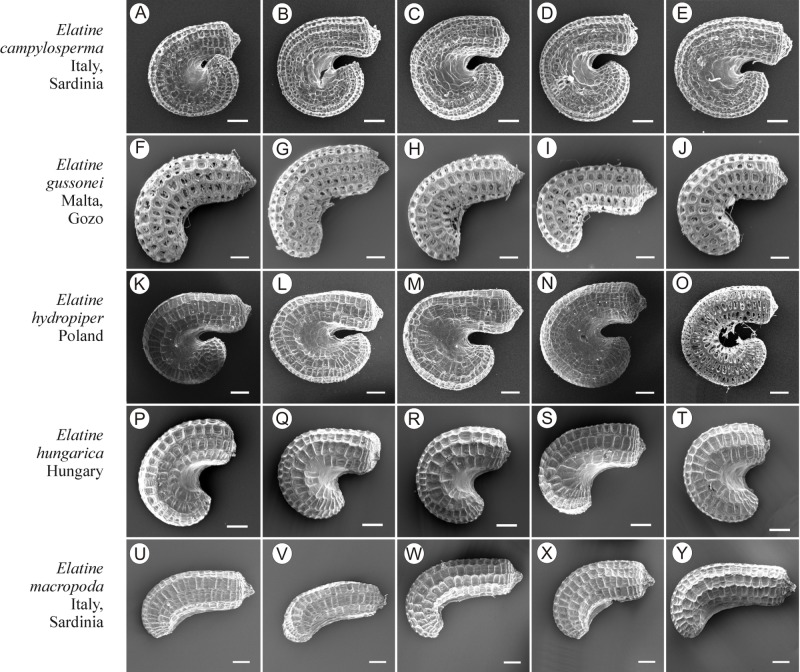
The diversity of seeds of Elatine campylosperma, E. gussonei, E. hydropiper, E. hungarica, E. macropoda.Scale bar =200 µm. (A–E) E. campylosperma; (F–J) E. gussonei; (K–O) E. hydropiper; (P–T) E. hungarica; (U–Y) E. macropoda.